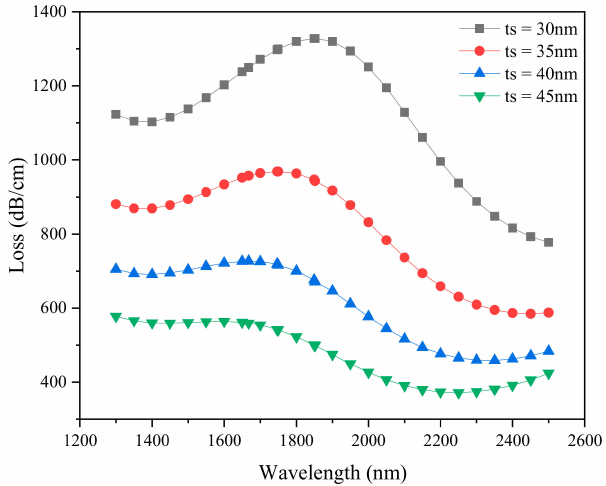
Figure 4. Loss spectrum of silver layer thickness which changes with wavelength obtained by simulation. ( d 1 = 0.5 µ m, d 2 = 0.7 µ m, d 3 = 1 µ m, Λ = 2 µ m, L = 1, RI =